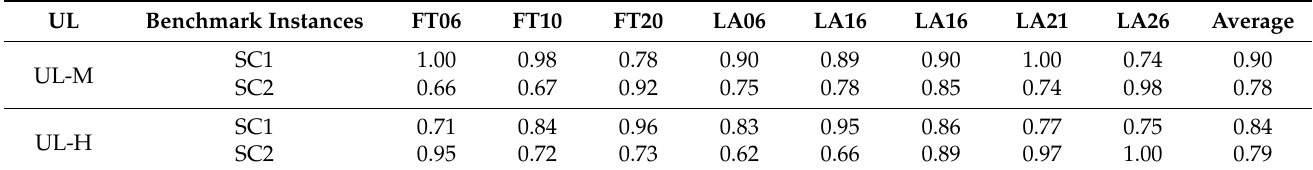
Table 5. The SC of the Pareto optimal solutions obtained by RMsim and SRM-R.